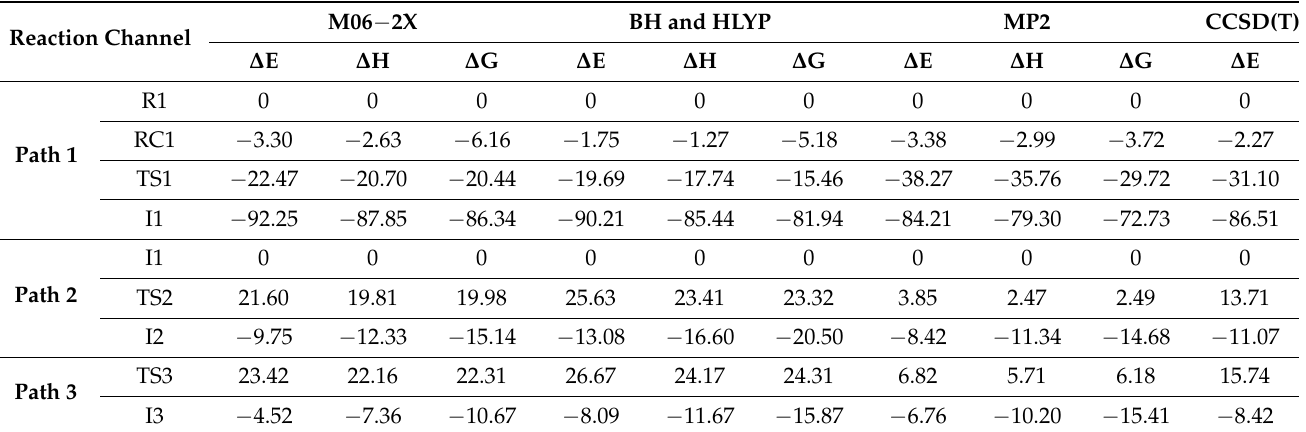
Table 3. The relative energy, enthalpy and Gibb’s free energy (in kcal/mol) for the reaction of trans-2-pentenal with O 3 calculated at 6-311++G(d,p) basis set level. Reaction Channel